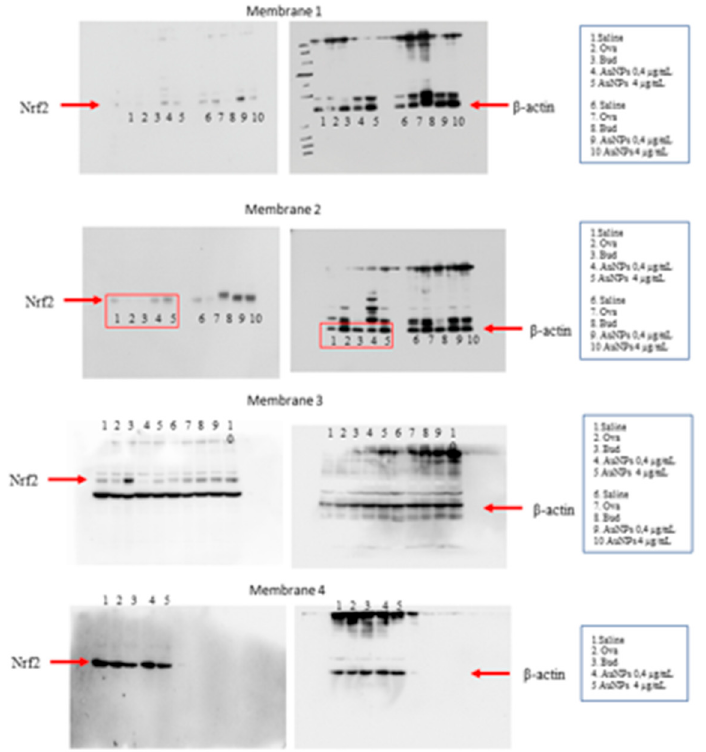
Figure A4. Upload of full gels for all Western blot images used to quantify Nrf2 as shown in Figure 5C. Red rectangles indicate lanes presented as representative blots in Figure 5C.